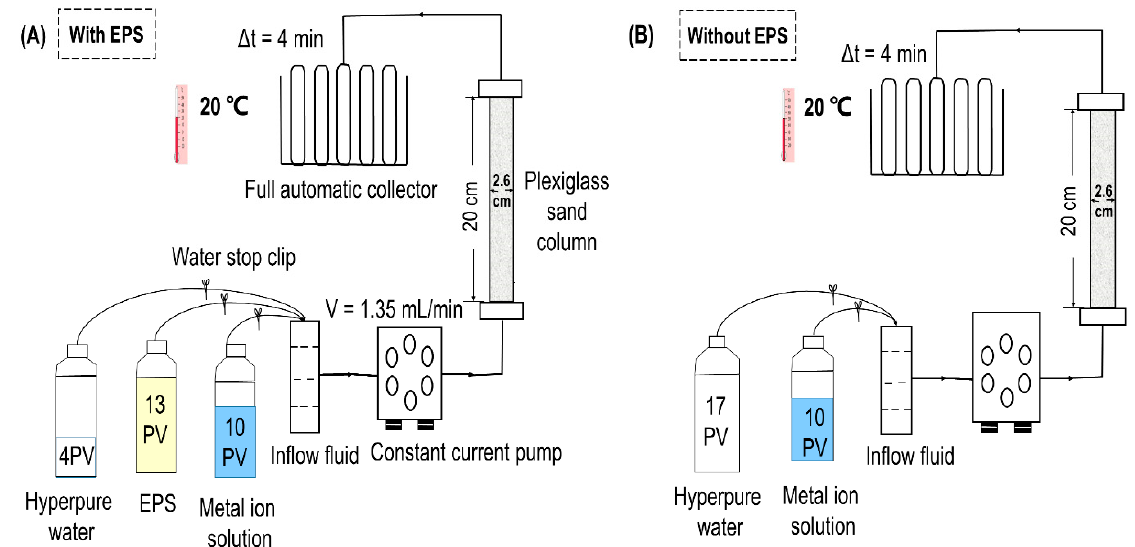
Figure 2. Schematic diagram of experimental device for the EPS/HMs breakthrough: ( A ) HMs breakthrough with EPS; ( B ) HMs breakthrough without EPS. PV—Pore volume; V—Velocity of flow.